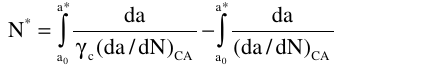
Table 5. Values of the crack length a* and the stress intensity factor range ∆ K* as predicted by the Willenborg model at the end of the delay zone. Specimen = 1.8 OL